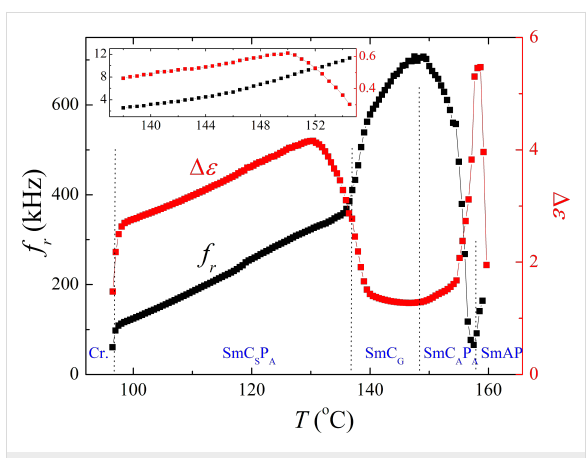
Figure 11: Temperature dependence of the dielectric strength, Δε , and relaxation frequency, f r , for IIb .